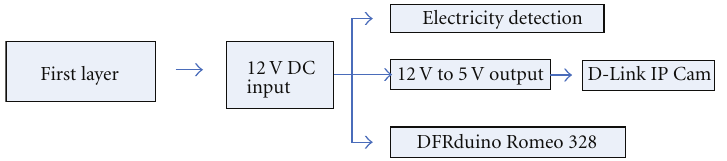
Figure 8: The sketch of first